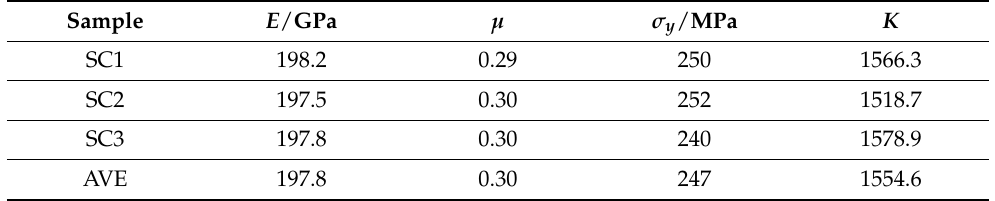
Figure 2. True stress versus true strain curves ( a ) obtained from uniaxial tensile tests of three flat coupons ( b ). Table 2. Material properties of 304 stainless steel.